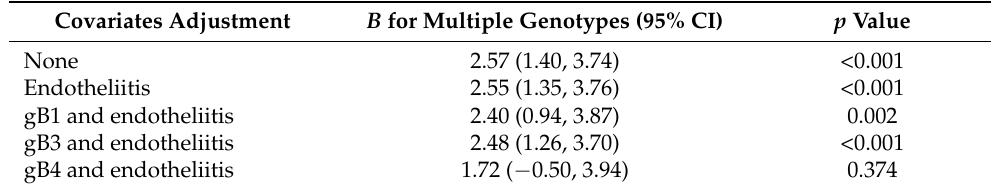
Table 4. The association between viral load (log-transformed) and multiple genotypes in the linear regression model with different